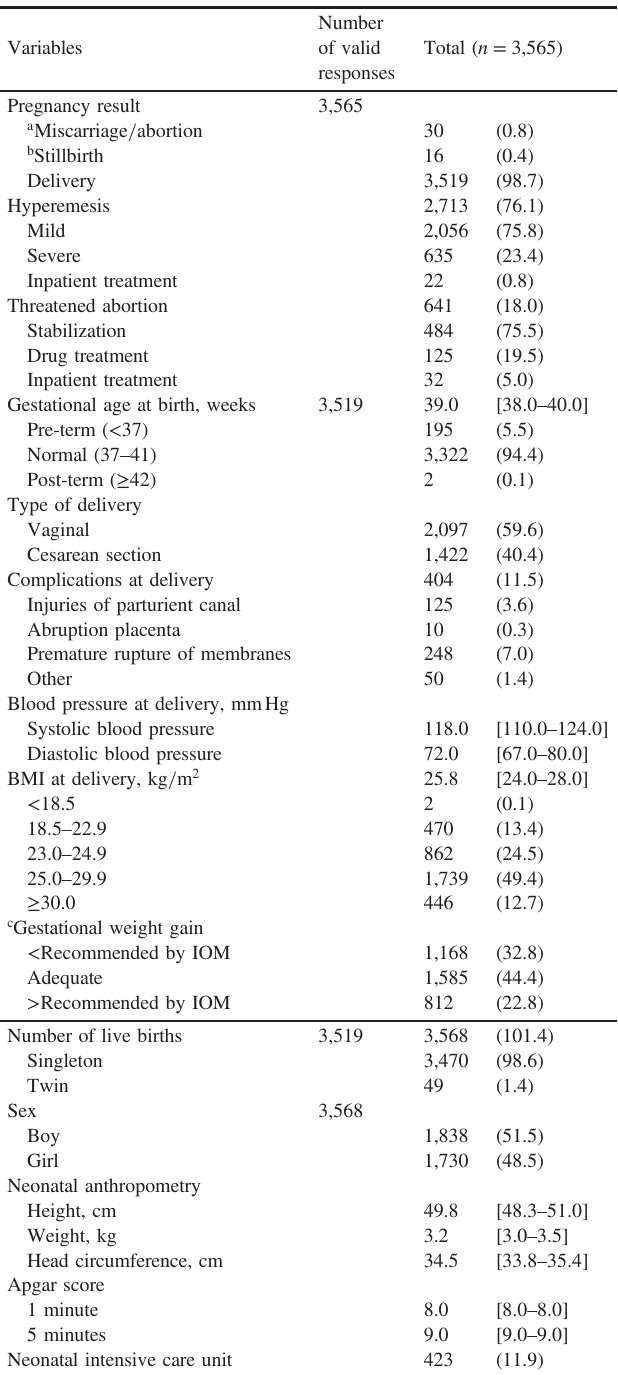
Table 5. Frequency of pregnancy-related complications Table 4. Pregnancy